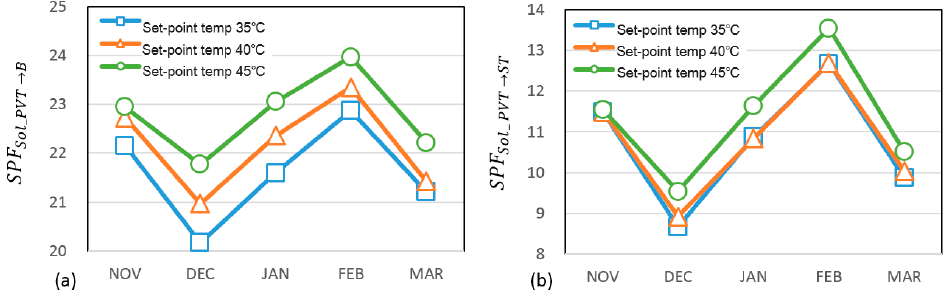
Figure 31. Heat production in PVT module ( a ) for building heating ( b ) for heat storage according to Change of solar heating temperature.